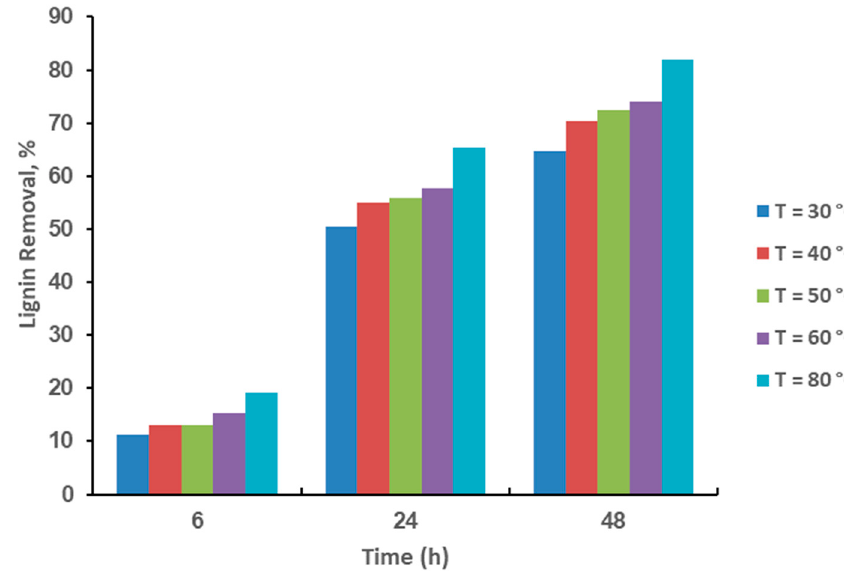
Figure 2. Effects of CHPA pretreatment time and temperature on lignin reduction.